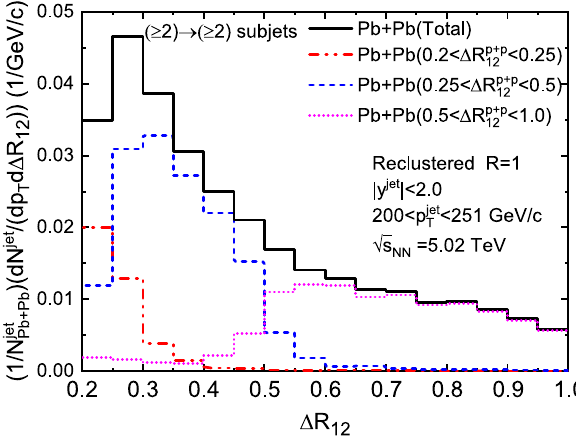
Fig. 9 MediummodificationonthehardestLRjetsplittingangle (cid:2) R 12 from ( ≥ 2 ) → ( ≥ 2 ) processes to reclustered LR jet distributions as a function of the hardest jet splitting angle (cid:2) R 12 of medium-modified √ s NN = 5 . 02 reclustered LR jets at